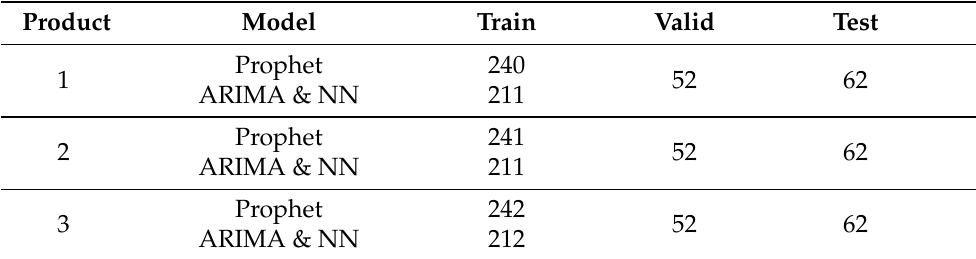
Table 2. Dataset size (# of datapoints) for each product and forecasting model.